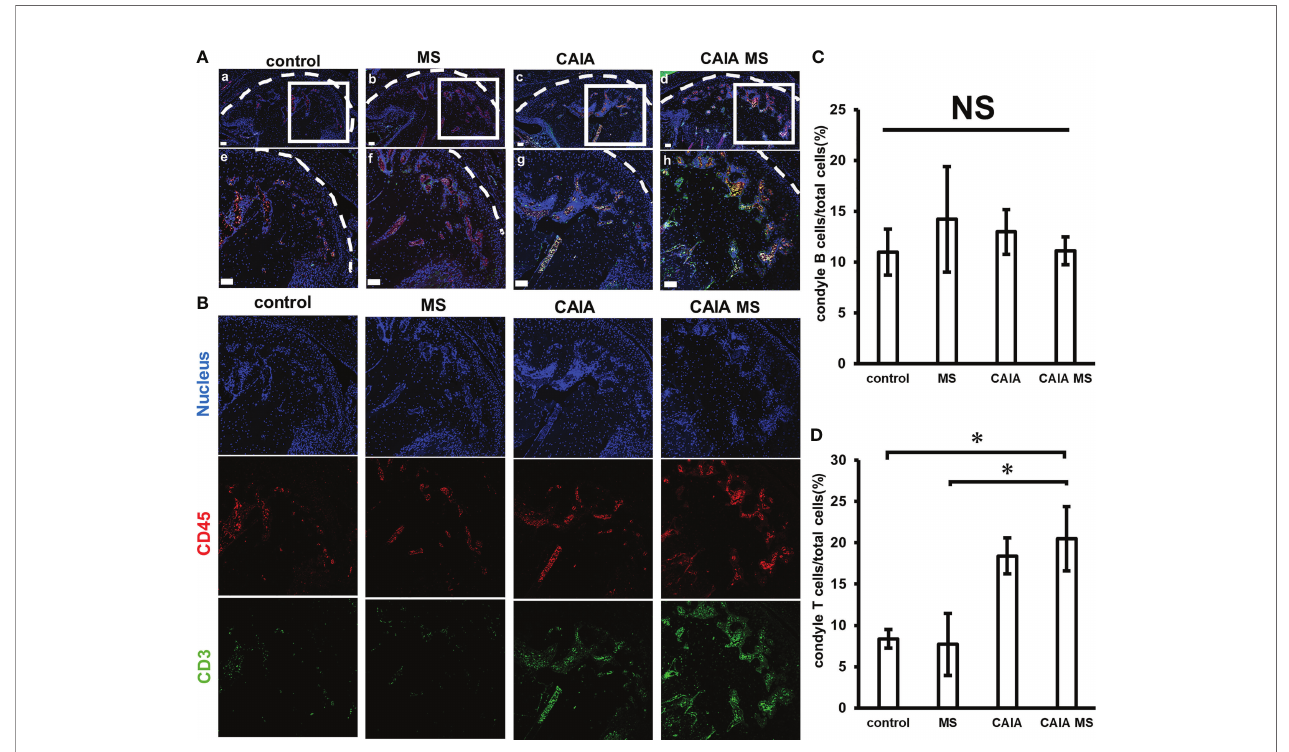
FIGURE 5 | Expression of T cells and B cells in the mandibular condyle by immuno fl uorescence staining. (A) Expression of mandibular condyle B cells and T cells (a – d) low magni fi cation, and (e – h) high magni fi cation. (scale bar: 50 m m; red: B cells, green: T cells, blue: cell nuclei). T cells and B cells are expression in the subchondral bone of each group. (B) Expression of B cells and T cells in the mandibular condyle by immuno fl uorescence staining. Representative images of 20x are shown in blue for nucleus, red for CD45, and green for CD3 for each group. (C) Number of B cells in the mandibular condyle vs. the total number of cells (percentage). *P < 0.05 (D) Number of T cells in the mandibular condyle vs. the total number of cells (percentage). *P < 0.05. NS, not signi fi